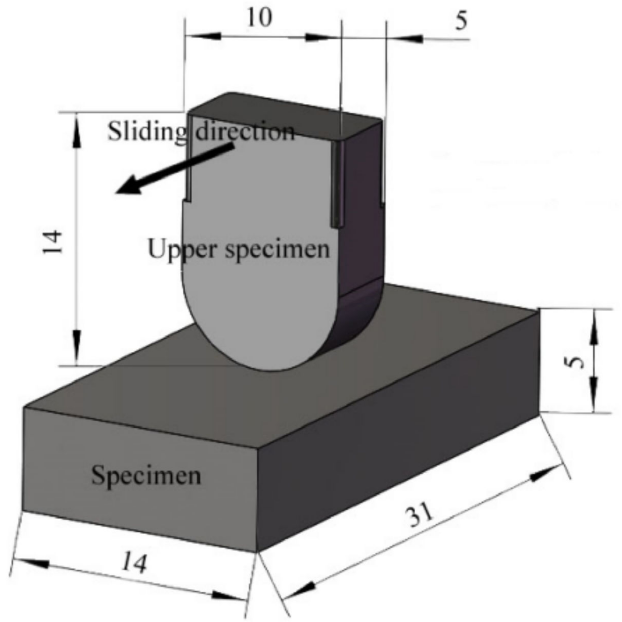
Figure 5. Schematic diagram of sample structure